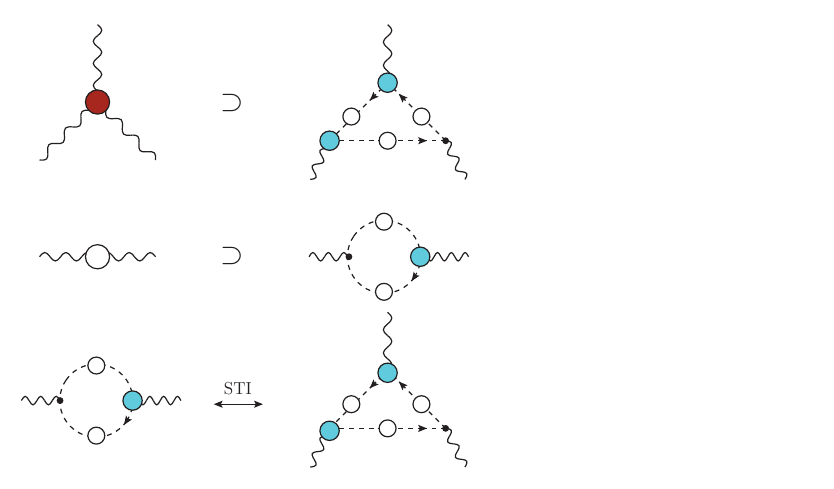
Figure 17. The ghost triangle present in the three-gluon vertex SDE (top) and the ghost loop con- tributing to the gluon propagator in the corresponding equation (middle). The infrared divergences arising from these diagrams are connected through the Slavnov–Taylor identity (STI) of Equation (23), as shown schematically in the bottom